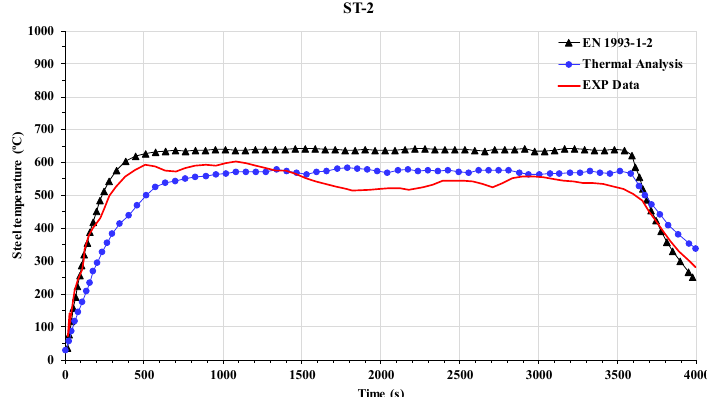
Figure 17. Steel temperature over time at ST-2.